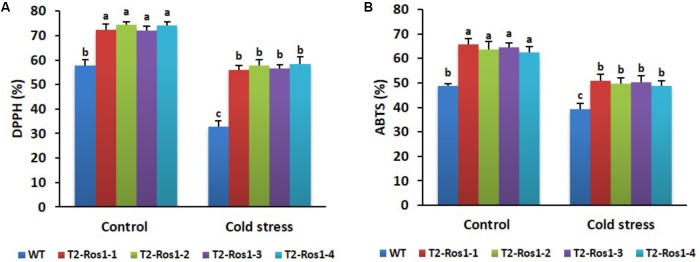
Comparison of ROS scavenging activities between 9-week-old WT and four independent T2-Ros1 lines under cold stress and normal growth conditions; (A) DPPH and (B) ABTS activities. Data were taken on the 21st day after starting the experiments. Error bars indicate the SE of means of three replicates. Means with different letters are significantly different (DMRT, p < 0.05).